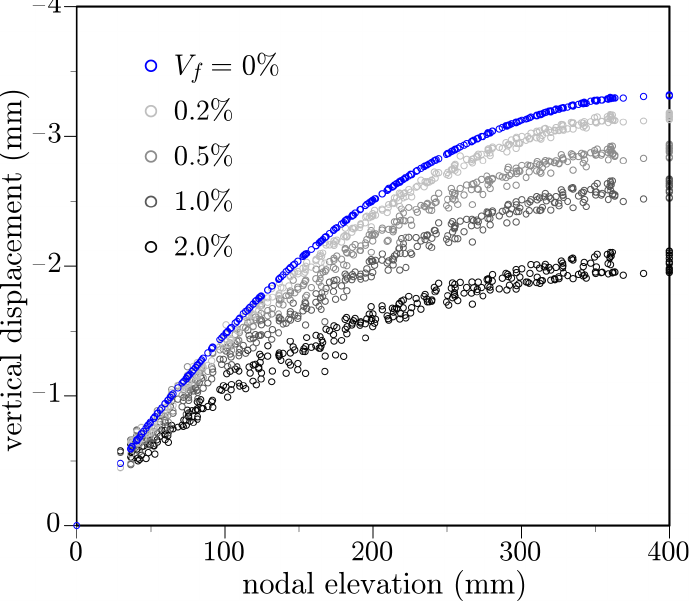
Figure 16. Effect of stiffening fiber dosage on the vertical displacement of all nodal points at t = 150